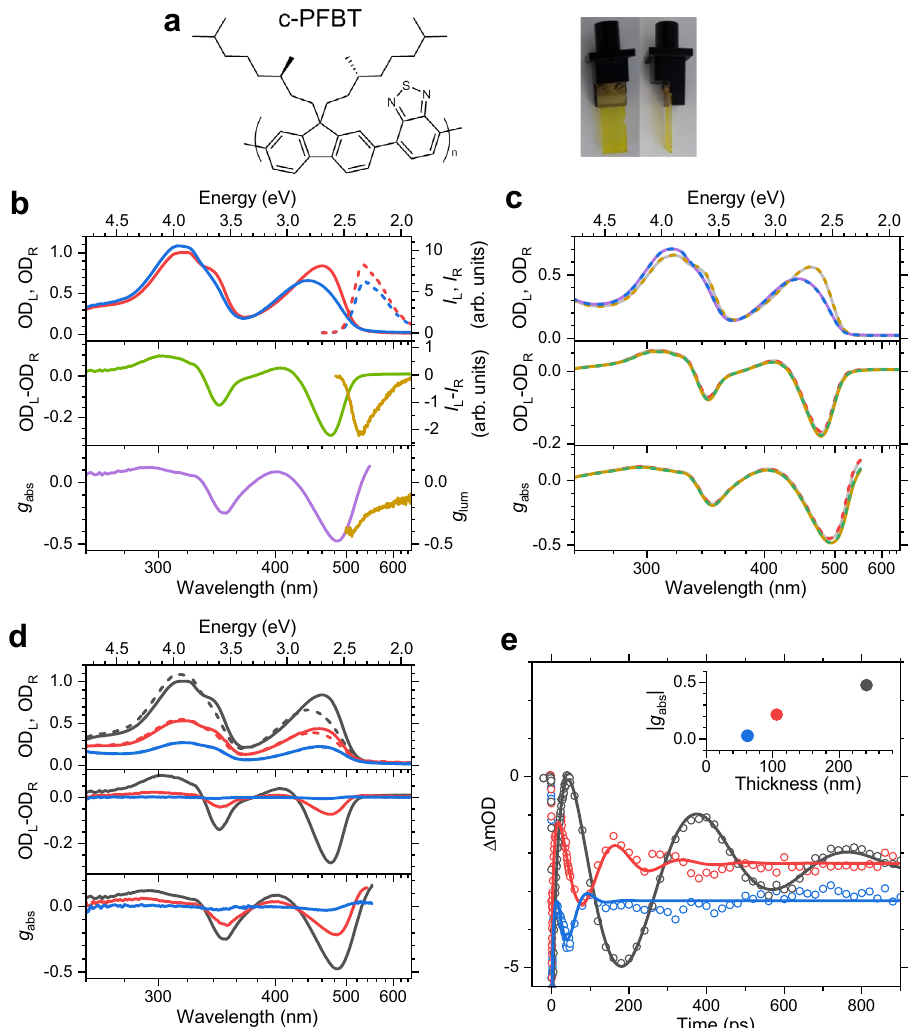
Fig. 1 Optical properties of the c-PFBT thin fi lms. a Chemical structure of the c-PFBT copolymer and pictures of the thin fi lm on glass. b Absorption spectra for left-circularly (blue solid line) and right-circularly polarised light (red solid line); emission spectra for left-circularly (blue dashed line) and right- circularly polarised light (red dashed line); CD spectrum (green line) and CPL spectrum (brown line); dissymmetry parameters g abs (violet line) and g lum (brown line). c Behaviour upon fl ipping and turning of the fi lm: Absorption spectra for left-circularly polarised light (front side: grey solid line, backside: brown dashed line) and right-circularly polarised light (front side: violet solid line, backside: blue dashed line); CD spectra and g abs (front side: grey solid line, front side turned by 180°: red dashed line, backside: brown solid line, backside turned by 180°: green dashed line). d Thickness-dependent absorbance (left-circularly polarised light: dashed lines, right-circularly polarised light: solid lines), as well as CD and g abs for thin fi lms with the thickness 62 nm (blue), 106 nm (red) and 241 nm (black). e Transient absorption signals averaged over the probe wavelength range 470 − 510 nm (open circles) showing oscillations due to a coherent acoustic phonon excited by the 320 nm pump laser pulse for thin fi lms with the thickness 62 nm (blue), 106 nm (red) and 241 nm (black); solid lines represent the respective fi ts using a sum of a biexponential function and a damped cosine function; the inset shows the absolute peak value of g abs as a function of fi lm thickness, suggesting a supramolecular origin of the chiroptical